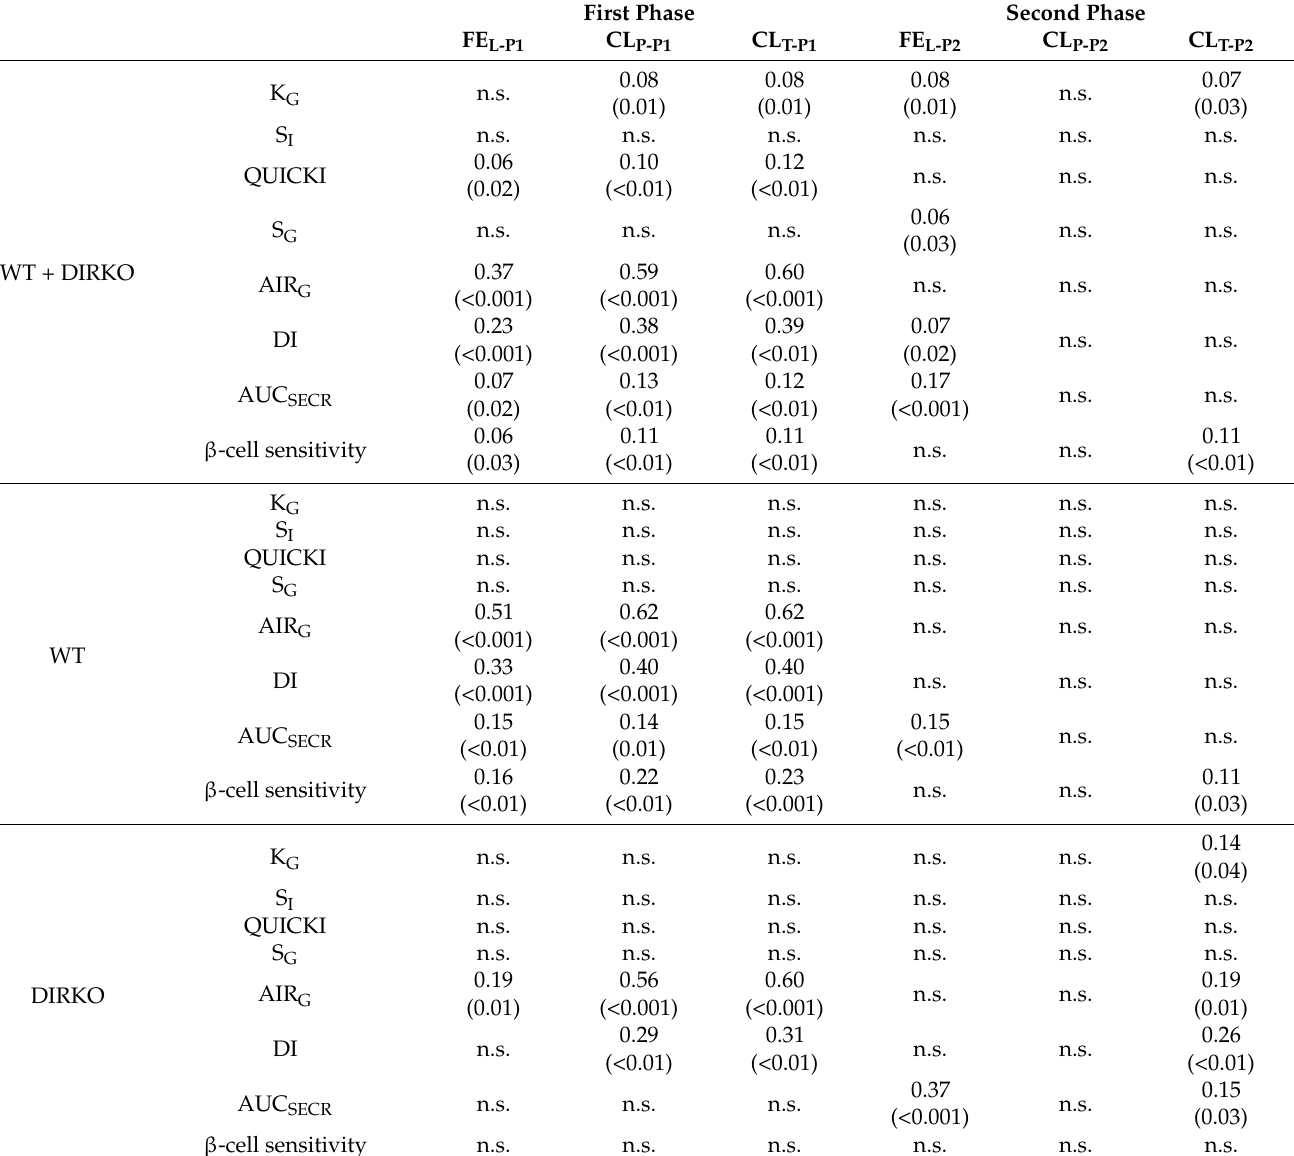
Table 3. Association between insulin clearance and the other metabolic parameters. First